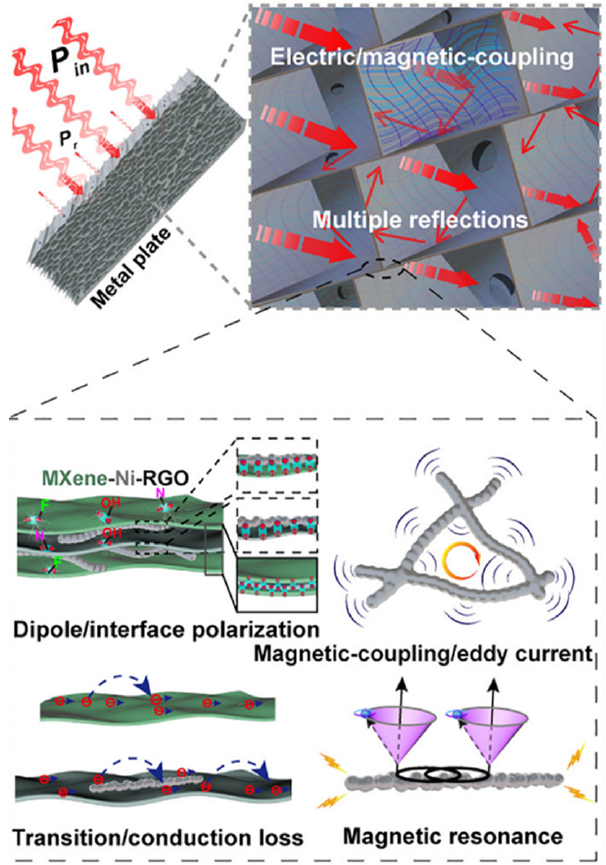
Figure 18. Schematic illustrations of the EM absorption mechanism of Ni/MXene/rGO aerogel. Reproduced with permission from ref. [167]. Copyright 2021, American Chemical Society.